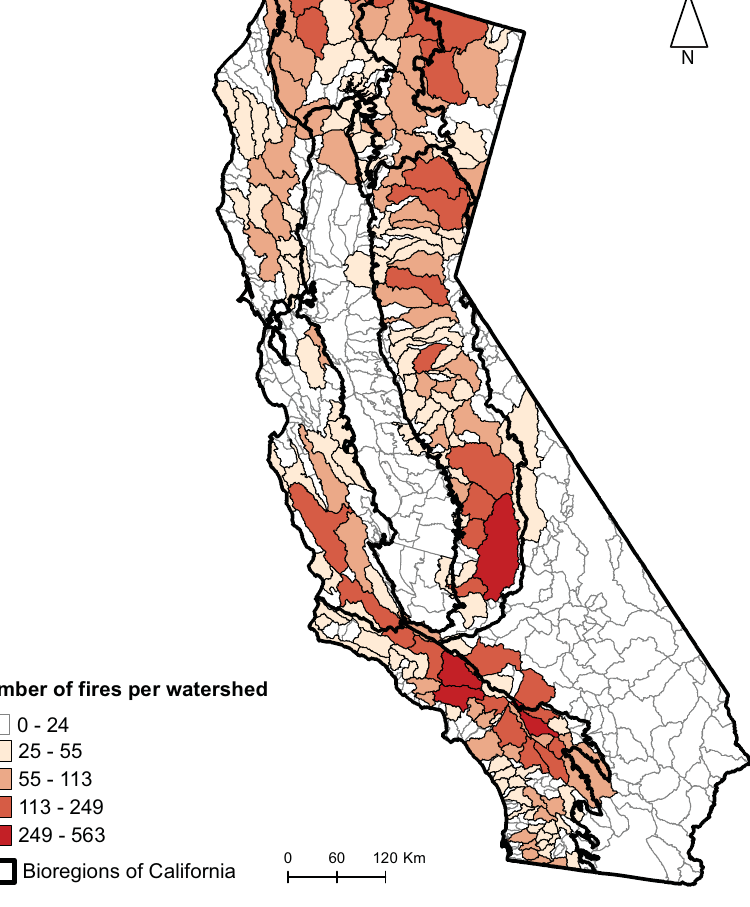
Figure 2. Partition of California into hydrologic sub-units (watersheds) according to the CalWater map and number of fires per unit. Each fire was associated with the watershed containing its centroid. Watersheds with less than 25 observations were not included in this analysis (represented in